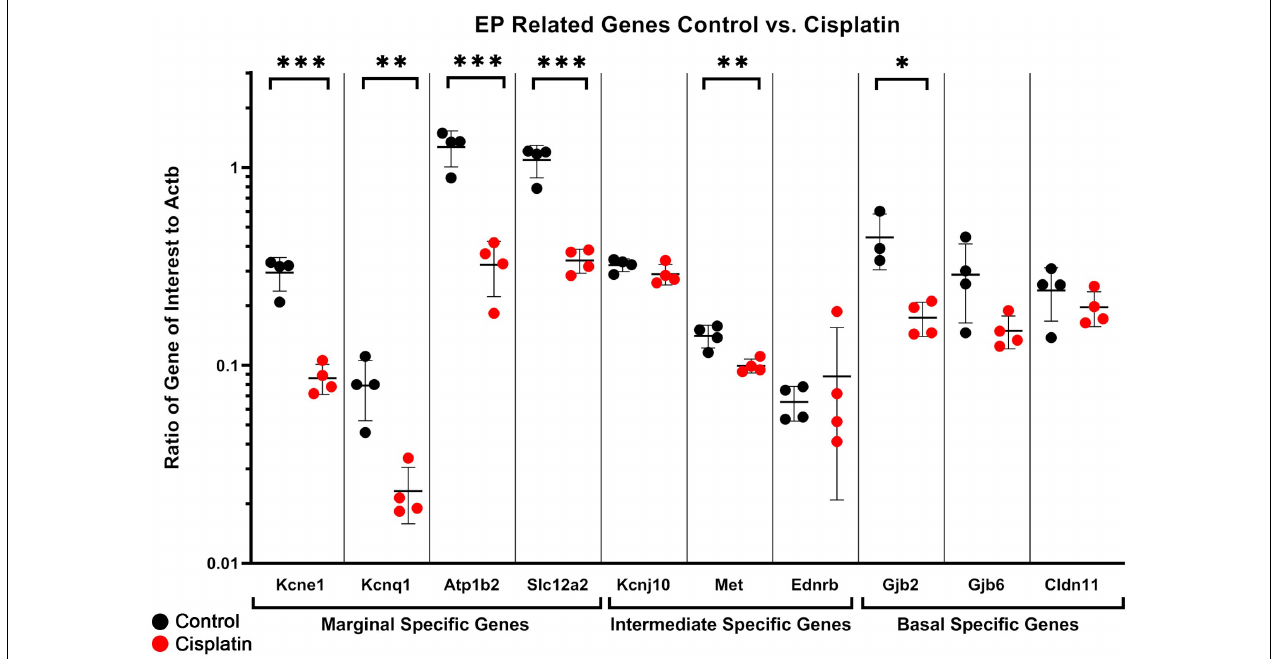
FIGURE 3 | ddPCR of dissected SV demonstrates a reduction in several EP-related genes after cisplatin treatment. In whole dissected SV, we observed a significant reduction in selected EP-related genes specific to marginal cells: Kcne1 ( q = 0.0020), Kcnq1 ( q = 0.0161), Atp1b2 ( q = 0.0020), and Slc12a2 ( q = 0.0020) (unpaired multiple t -test, Benjamini–Hochberg correction). A significant reduction in two EP-related genes specific to intermediate cells: Met (uncorrected p = 0.0064) and Kcnj13 (uncorrected p = 0.0117) was seen between control and cisplatin-treated mice (unpaired multiple t -test, Benjamini–Hochberg correction). Expression of other known intermediate cell-specific genes including Kcnj10 ( p = 0.1746) and Ednrb ( p = 0. 5309) were not reduced in cisplatin-treated compared to control. Expression of EP-related genes in basal cells, including Gjb2 ( q = 0.0207) was significantly reduced, while Gjb6 ( q = 0.1086), and Cldn11 ( q = 0.4012), were not decreased